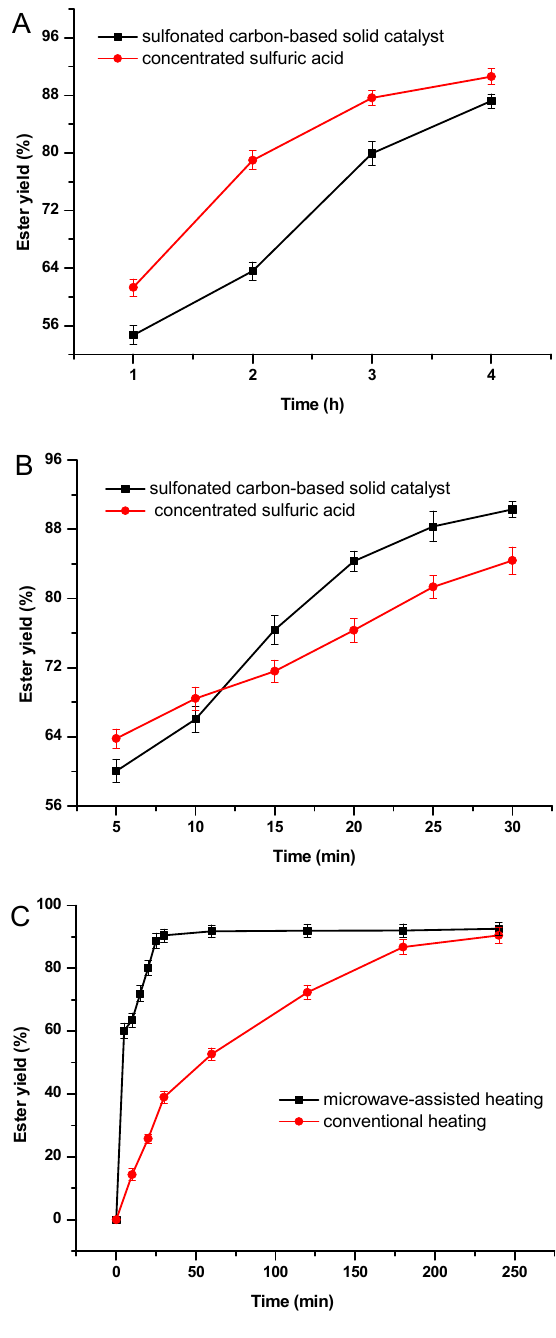
Figure 4. Comparison of ester yield between concentrated sulfuric acid and sulfonated carbon ‐ based solid catalyst. ( A ) Conventional heating, water bath 60 °C; ( B ) microwave radiation, microwave power density 1 W/mL; ( C ) comparison between conventional and microwave ‐ assisted heating with the sulfonated carbon ‐ based solid catalyst, microwave power density 1 W/mL, water bath: 60 °C.